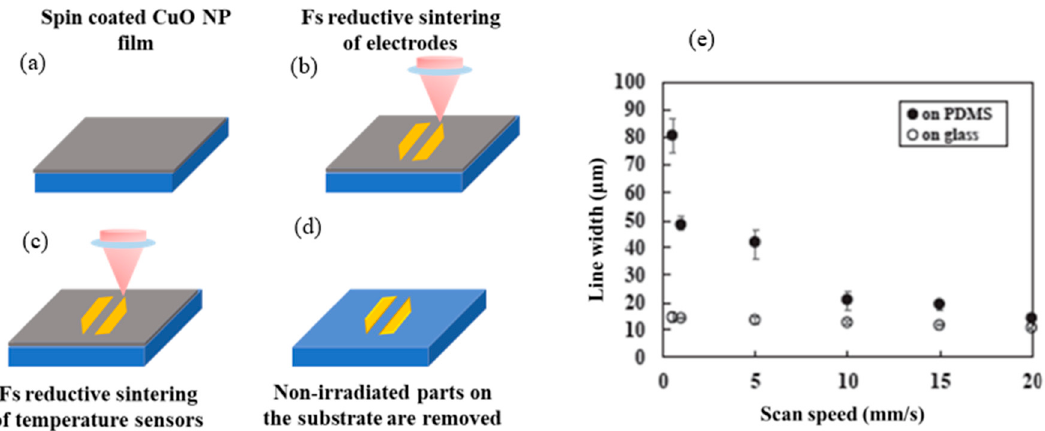
Figure 8. ( a ) Spin-coated CuO NP film; femtosecond reductive sintering of ( b ) electrodes, ( c ) temperature sensors and ( d ) non-irradiated parts on the substrate were removed; ( e ) fs laser reductive sintered line width on PDMS vs. glass as a function of the scanning speed